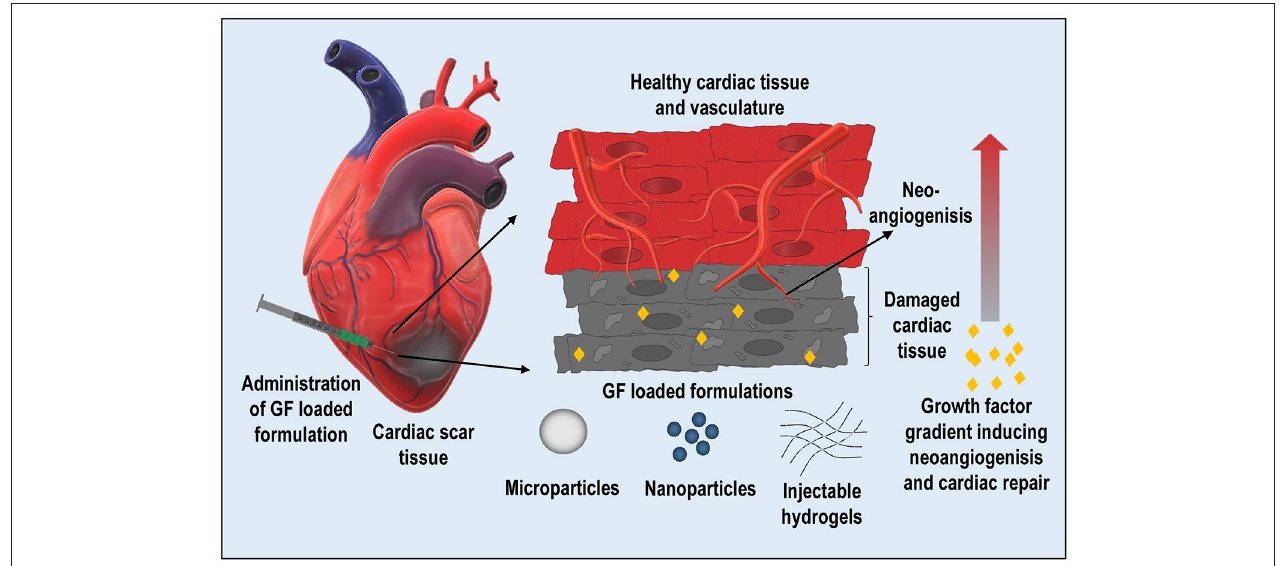
FIGURE 1 | Schematic representing the intramyocardial delivery of growth factor-loaded formulations (nanoparticles, microspheres, and hydrogels) for localized and sustained delivery for repairing the damaged cardiac tissue.